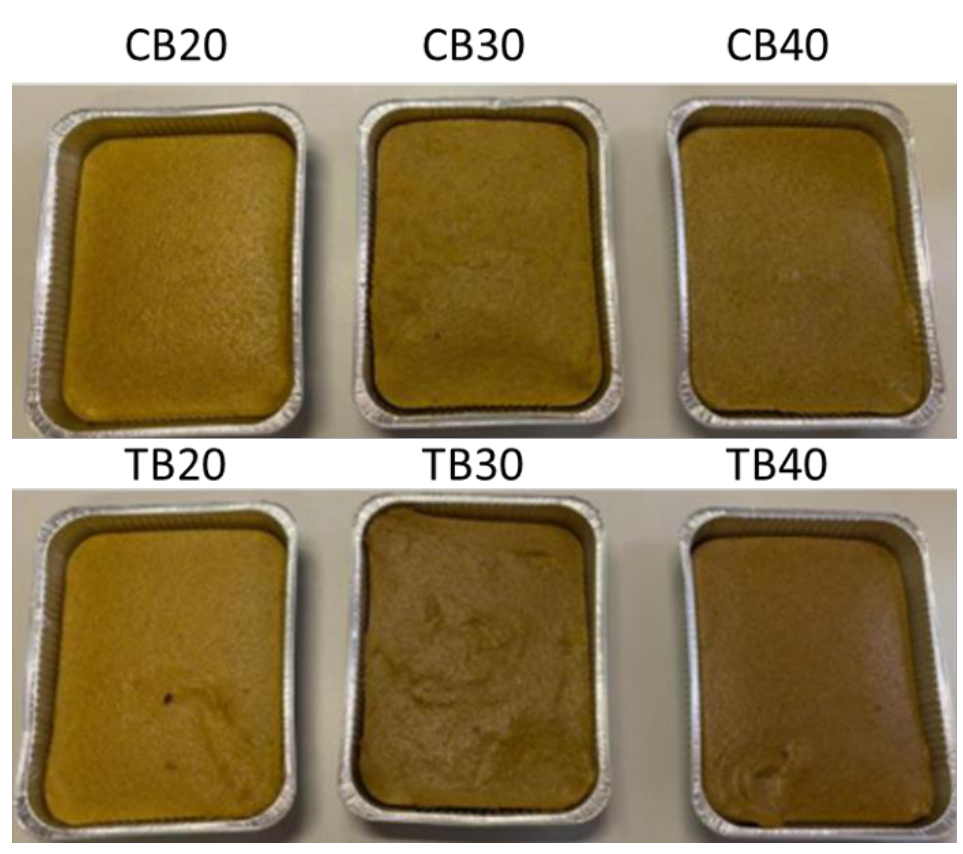
Figure 1. Polenta formulations with Common (CB) and Tartary buckwheat (TB) at 20% (CB20; TB20), 30% (CB30; TB30), and 40% (CB40; TB40). 30% (CB30; TB30), and 40% (CB40;